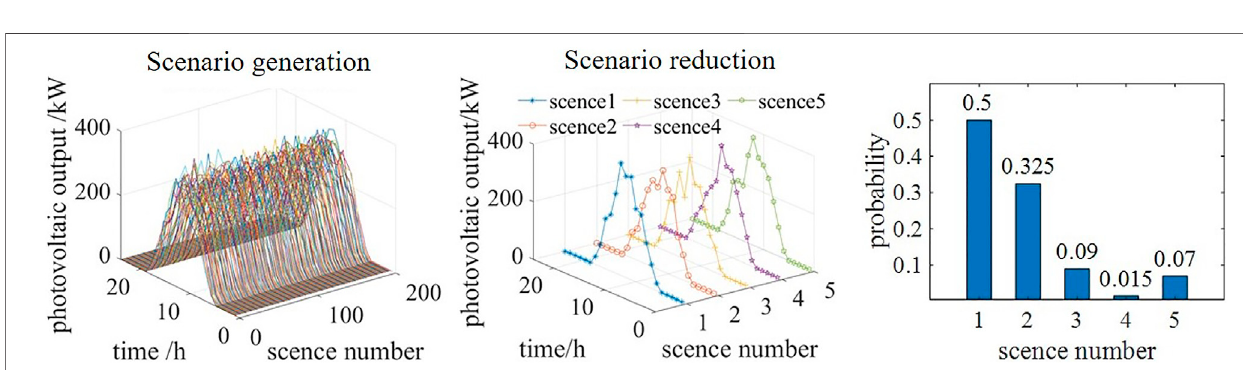
FIGURE 6 | Scenario generation and reduction of the photovoltaic unit output curve in Case 4.